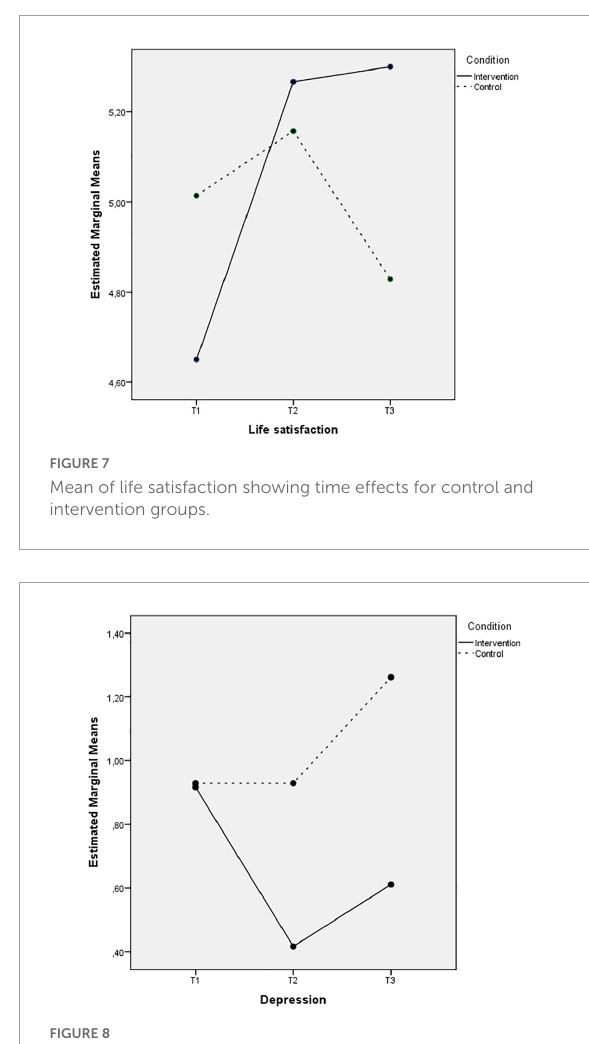
FIGURE8 Mean of depression showing time effects for control and intervention